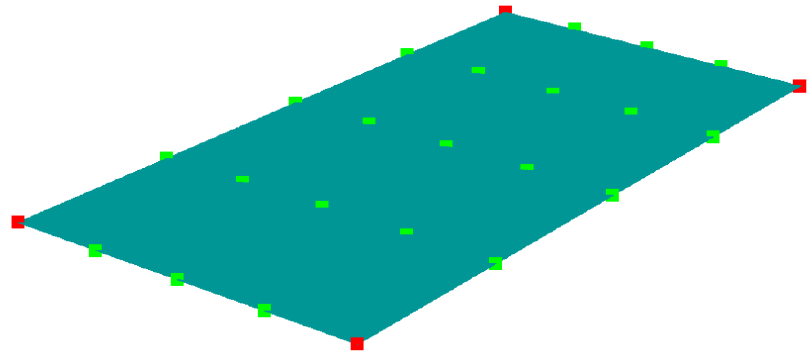
Table 1. Height discrepancies of single segment of synthetic data before, during and after the process and ROP corrections of the lidargram model.